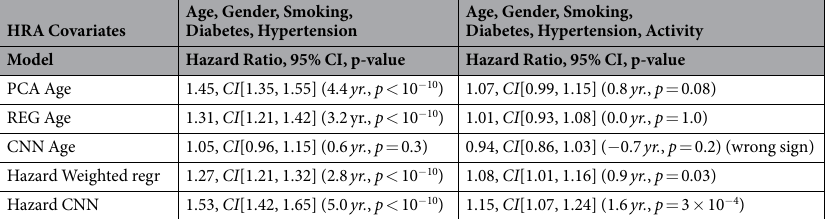
Table 2. Association of the biological age- and all-cause mortality -predicting models with all-cause mortality. Two class of models were evaluated: one including the HRA parameters: age, gender, diabetes, smoking and hypertension as covariates (the left column) and the other including additionally the negative logarithm of the average daily physical activity (the biological age proxy, the right column). The corresponding 95% hazard ratio intervals are given along with the significance p-value and the effect levels, expressed in years of life lost (see the text for